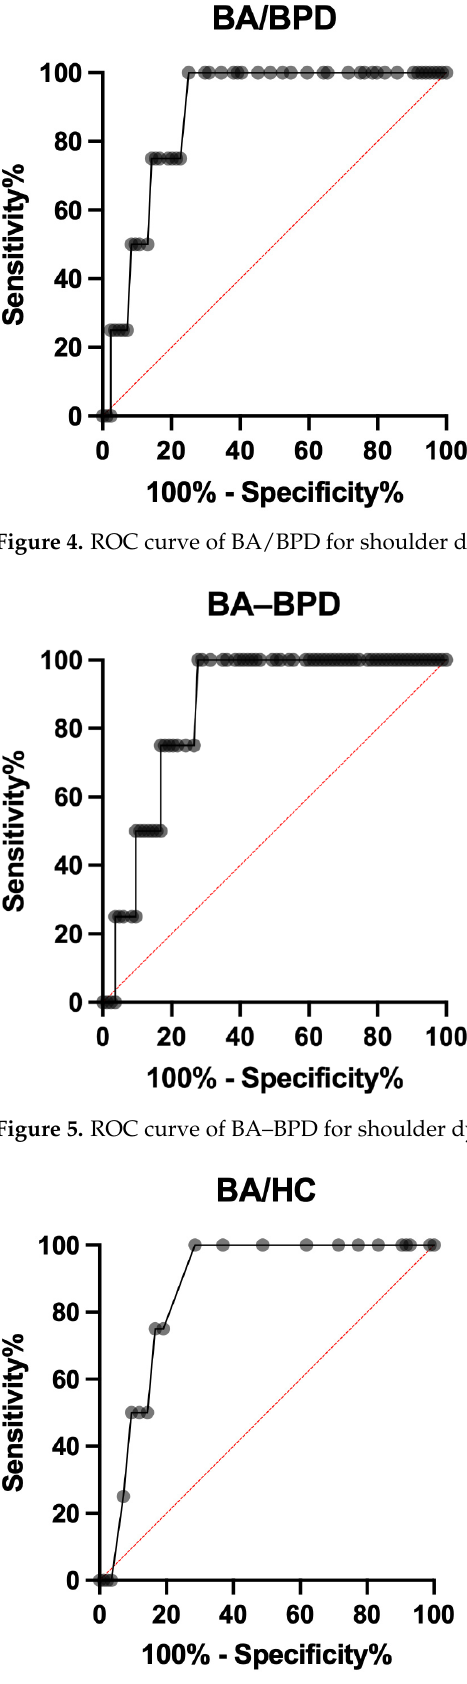
Figure 6. ROC curve of BA/HC for shoulder dystocia prediction.